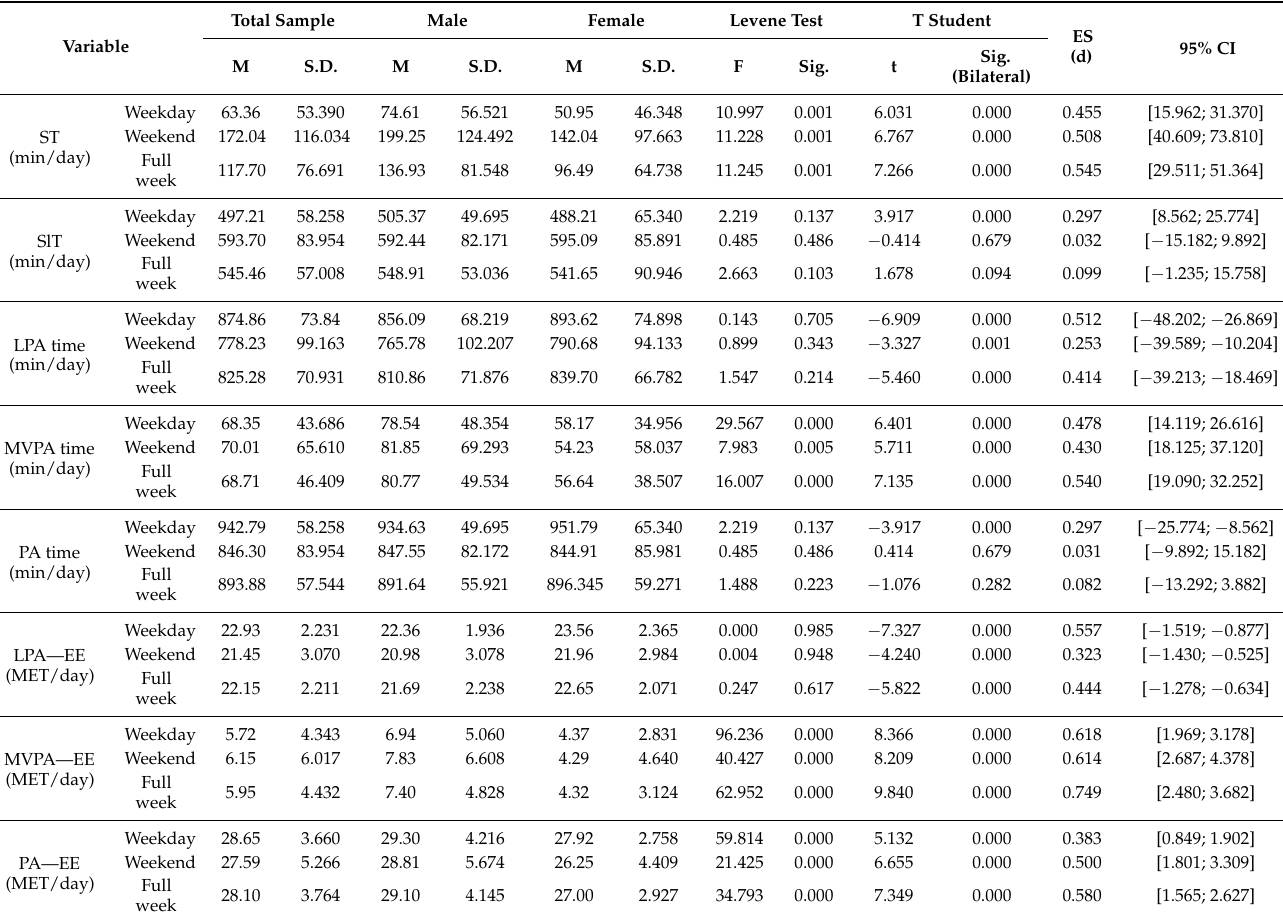
Table 2. Screen time, sleep time and physical activity according to the participants’